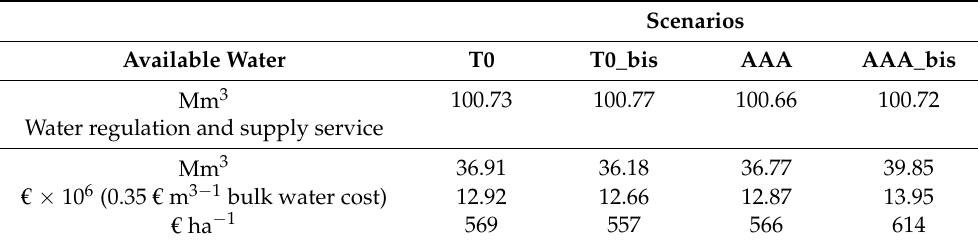
Table 5. Available water and water regulation and supply service values for each